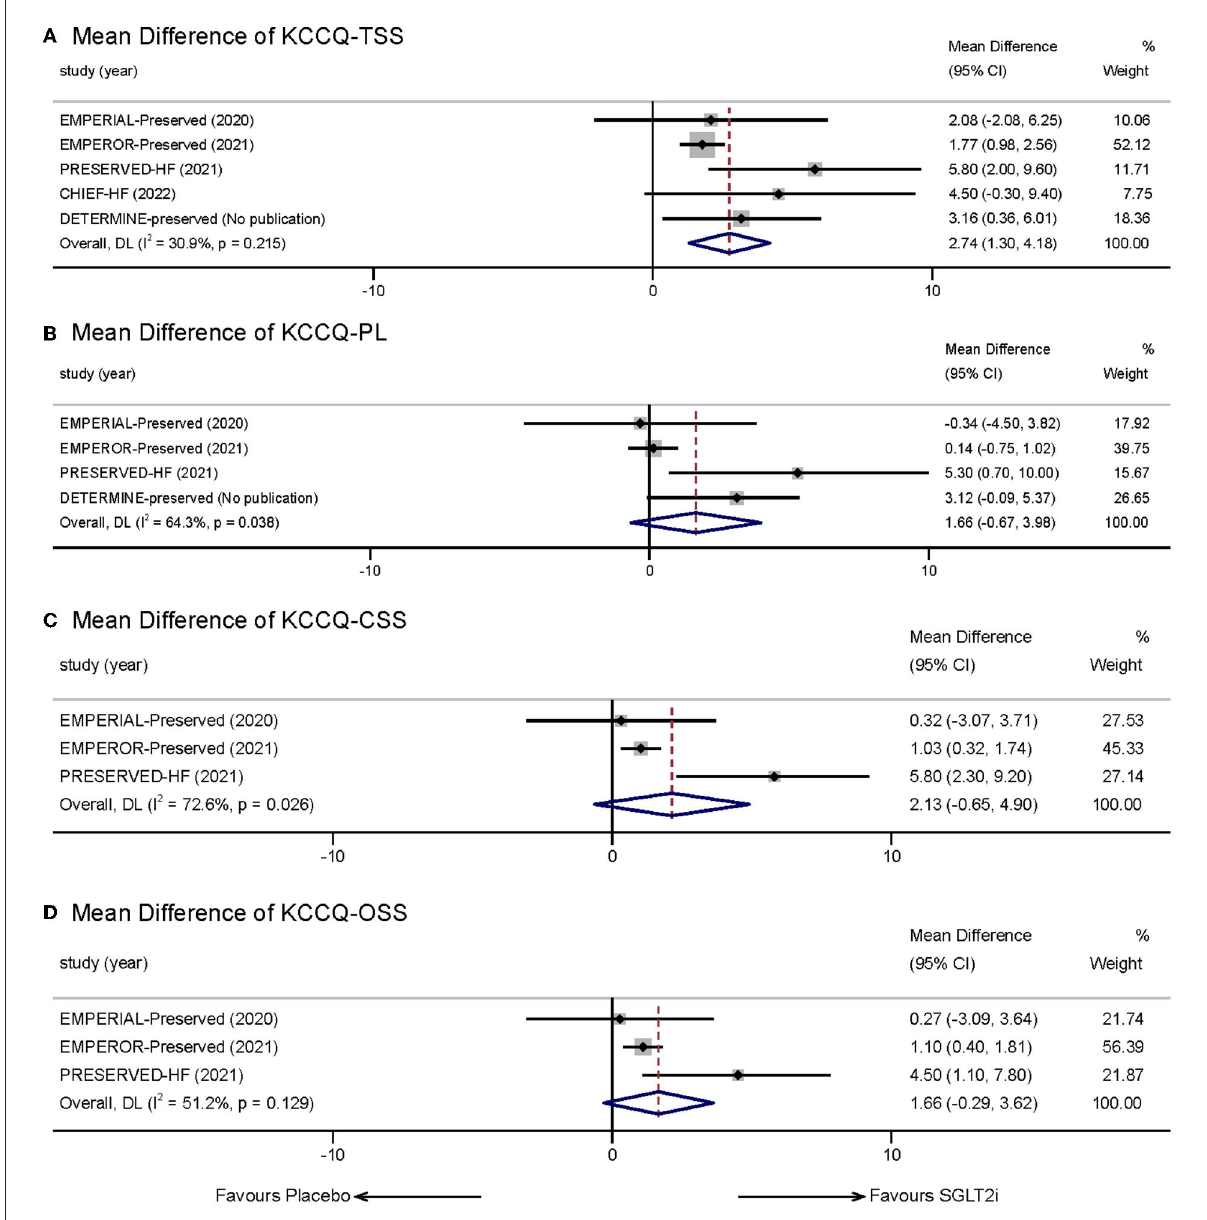
FIGURE4 Effect of SGLT-2 inhibitors vs. placebo on KCCQ Subscales: (A) KCCQ-TSS; (B) KCCQ-PL; (C) KCCQ-CSS; (D)